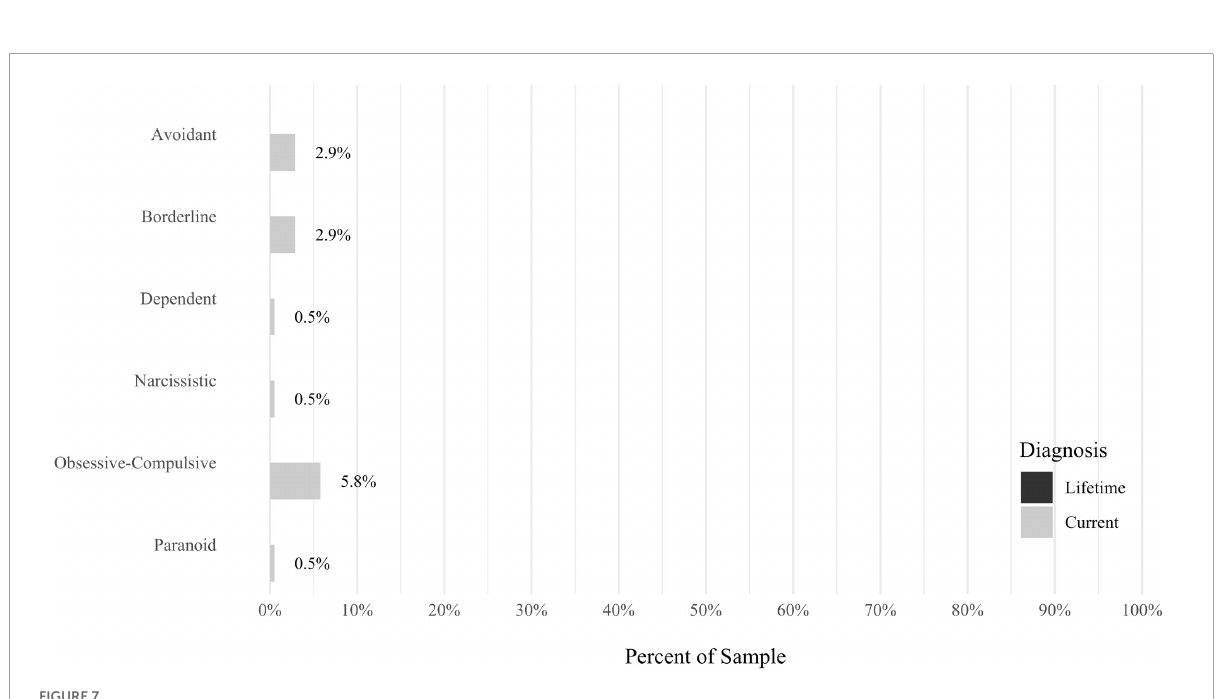
FIGURE7 Rates of psychiatric disorders: personality